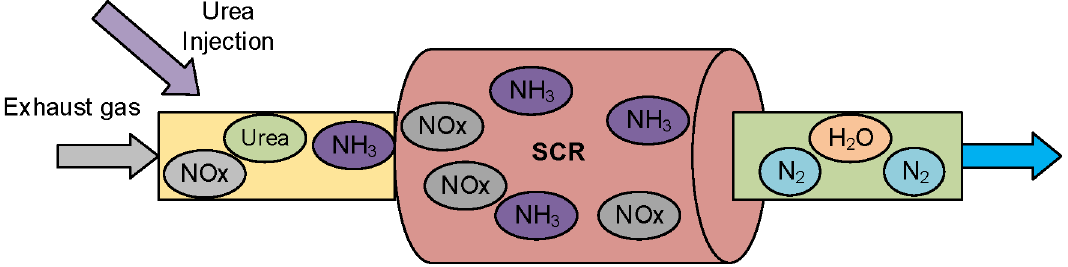
Fig 1. Schematic diagram of SCR